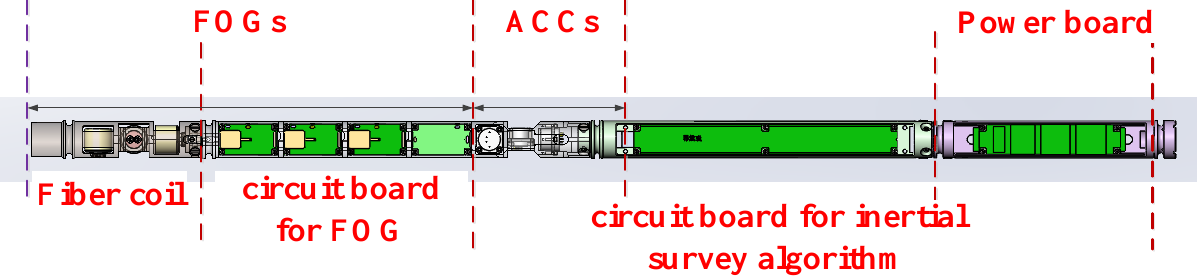
Figure 1. Schematic diagram of a FOG-based MWD. The flow chart of the FOG-based MWD measurement algorithm is represented in Figure 2 [6]. The FOG-based MWD are installed into the bottom hole, assembled with their